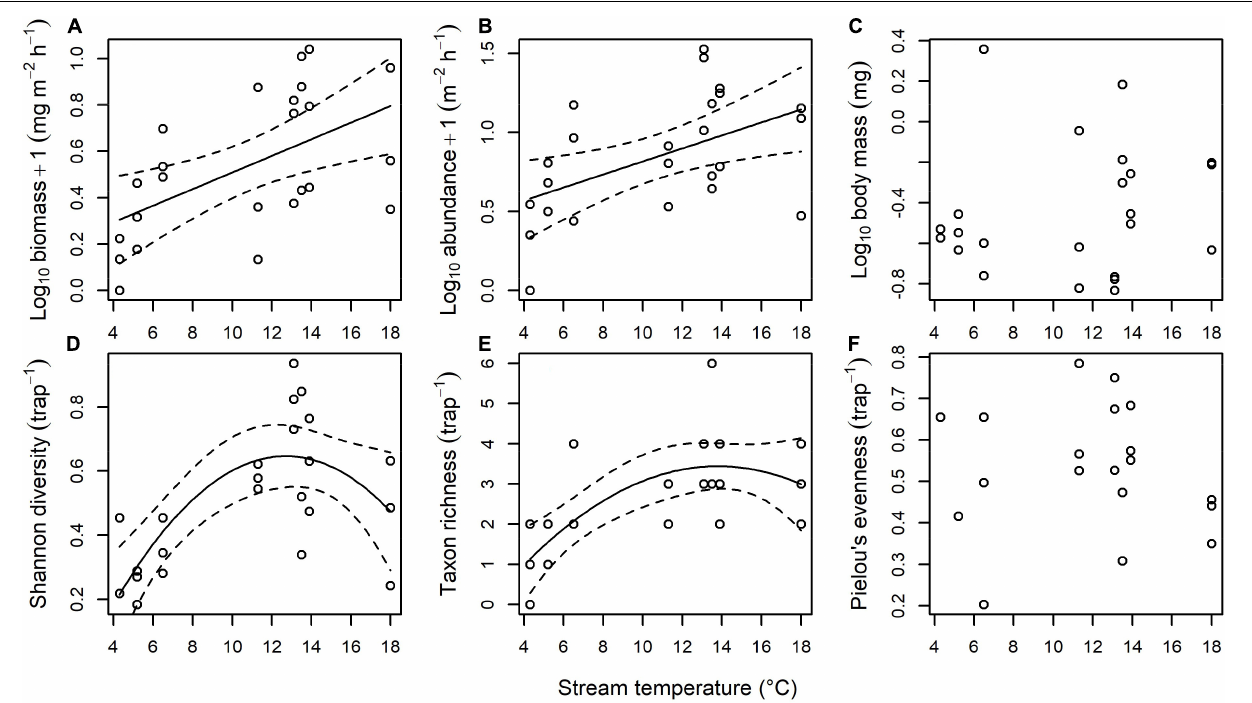
FIGURE 4 | Effect of stream temperature on the terrestrial subsidy of adult flies landing on the surface of the streams. There was a significant effect of temperature on (A) Biomass ( y = 0.151 + 0.036 x , p = 0.005, r 2 = 0.27), (B) abundance ( y = 0.404 + 0.041 x , p = 0.011, r 2 = 0.22), (D) Shannon diversity ( y = –0.342 + 0.156 x – 0.006 x 2 , p < 0.001, r 2 = 0.47), and (E) taxon richness ( y = –1.427 + 0.705 x – 0.026 x 2 , p = 0.001, r 2 = 0.42), with no significant effect of temperature on (C) body mass or (F) Pielou’s